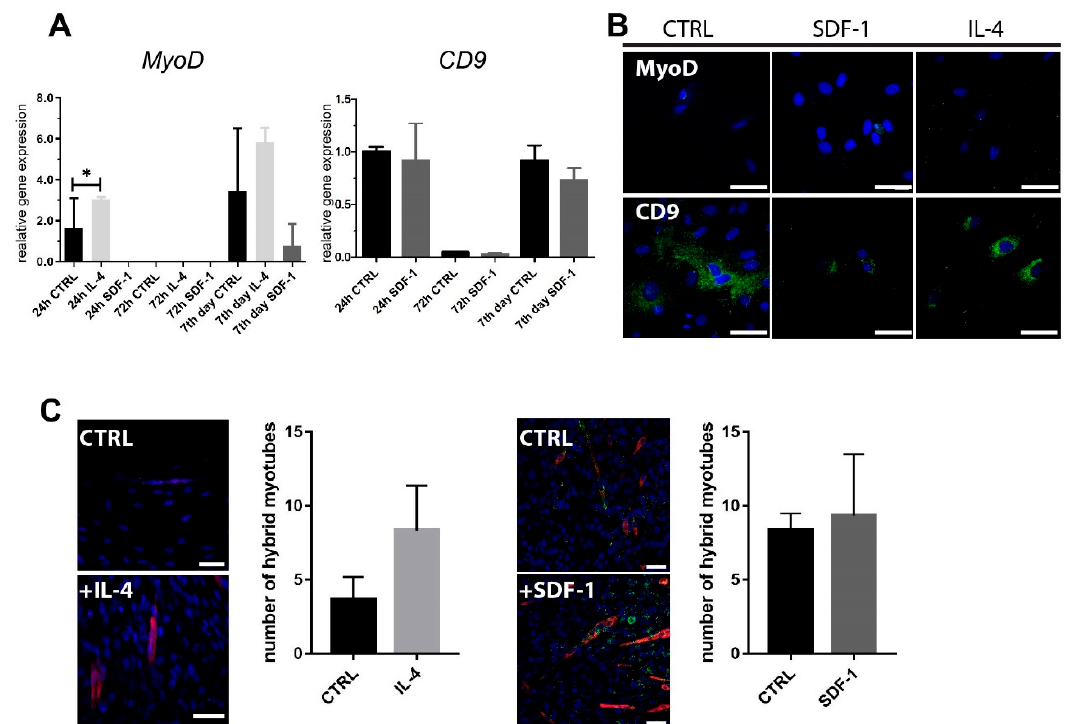
Figure 2. Analysis of expression of mRNA encoding myogenic factors and differentiation potential of rADSCs cultured under control conditions or in the presence of IL-4 or SDF-1. ( A ) Analysis of the level of mRNAs encoding MyoD and CD9. Expression was related to the levels observed in control cells at day 0 (beginning of the culture) and normalized to mRNA encoding HPRT; ( B ) Localization of MyoD and CD9 (green) and nuclei (blue); Bar: 50 µ m. ( C ) Co-culture between rADSCs and mouse C2C12 myoblasts. GFP (green), skMyHC (red), nuclei (blue). Bar: 50 µ m. N varied between 3 and 6. Data analyzed with of Student’s t -test: 2C (IL-4), data analyzed with Mann–Whitney U test: 2A, 2C (SDF-1). Data are presented as mean ± SD. * represents results: * p ≤ 0.05. CTRL—non-treated